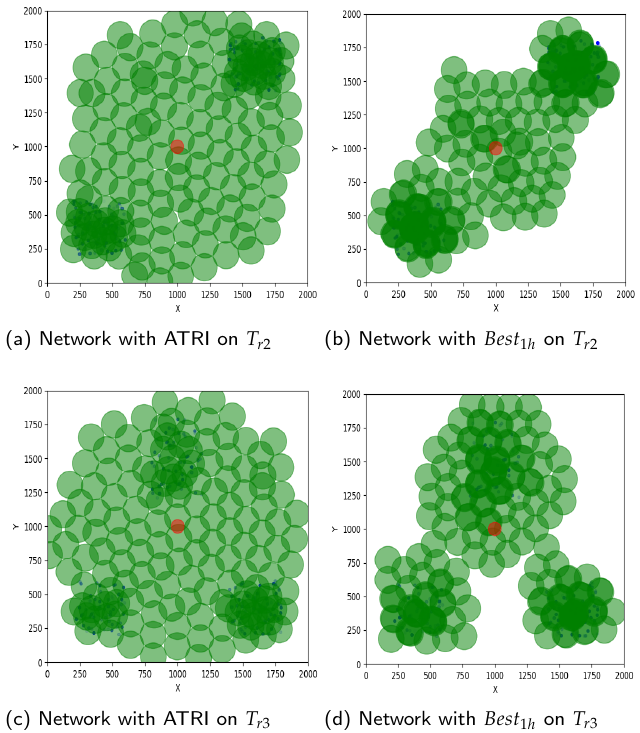
Figure 10. Network deployments of Best 1 h and ATRI on Tr 2 and Tr 3 . In both scenarios, Best 1 h performed better than ATRI because GANet allows UAVs to move toward users with bandwidth demand. Table 3. Comparing fitness with different numbers of UAVs and 200 users on training scenarios.